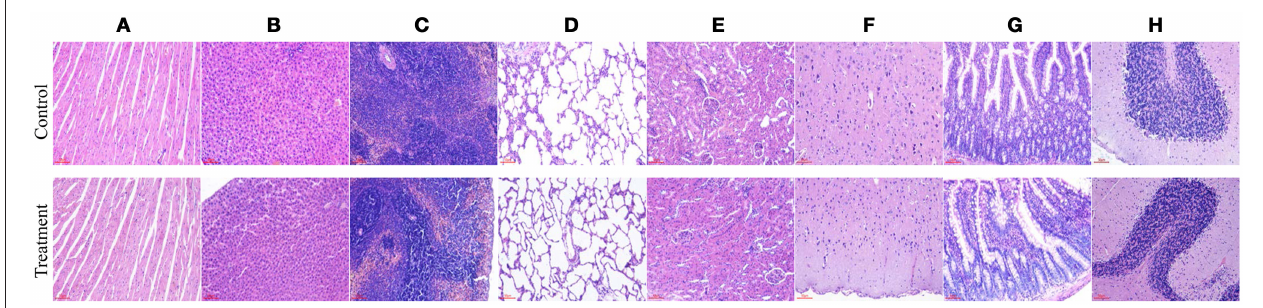
FIGURE 6 | Representative photomicrographs of organs of rats after oral administration of Enterococcus durans KLDS6.0930 for 28 days. Control, sterile normal saline; Treatment, 1 × 10 9 CFU of E. durans KLDS6.0930 /kg body weight (BW); (A) heart, (B) liver, (C) spleen, (D) lung, (E) kidney, (F) brain, (G) jejunum, (H) cerebellum. Bar = 50 µ m.